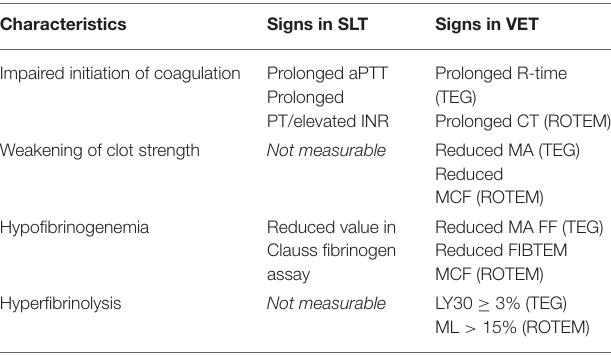
TABLE 1 | Signs of trauma-induced coagulopathy using standard laboratory testing (SLT) and viscoelastic testing (VET).